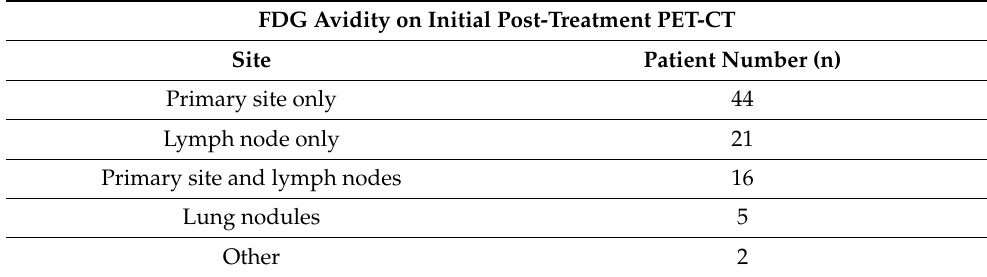
Table 2. Distribution of residual uptake on initial response assessment FDG